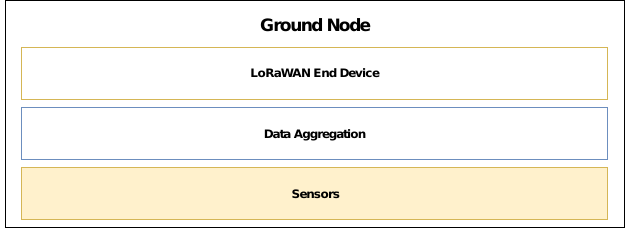
Figure 2. System stack of Ground Nodes (GNs).